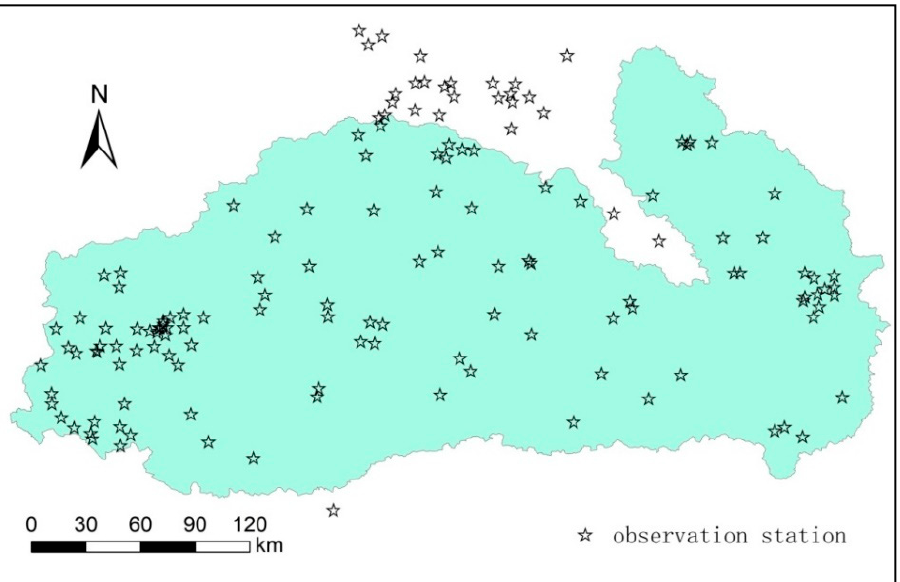
Figure 3. Location map of precipitation observation stations in the basin and surrounding areas.